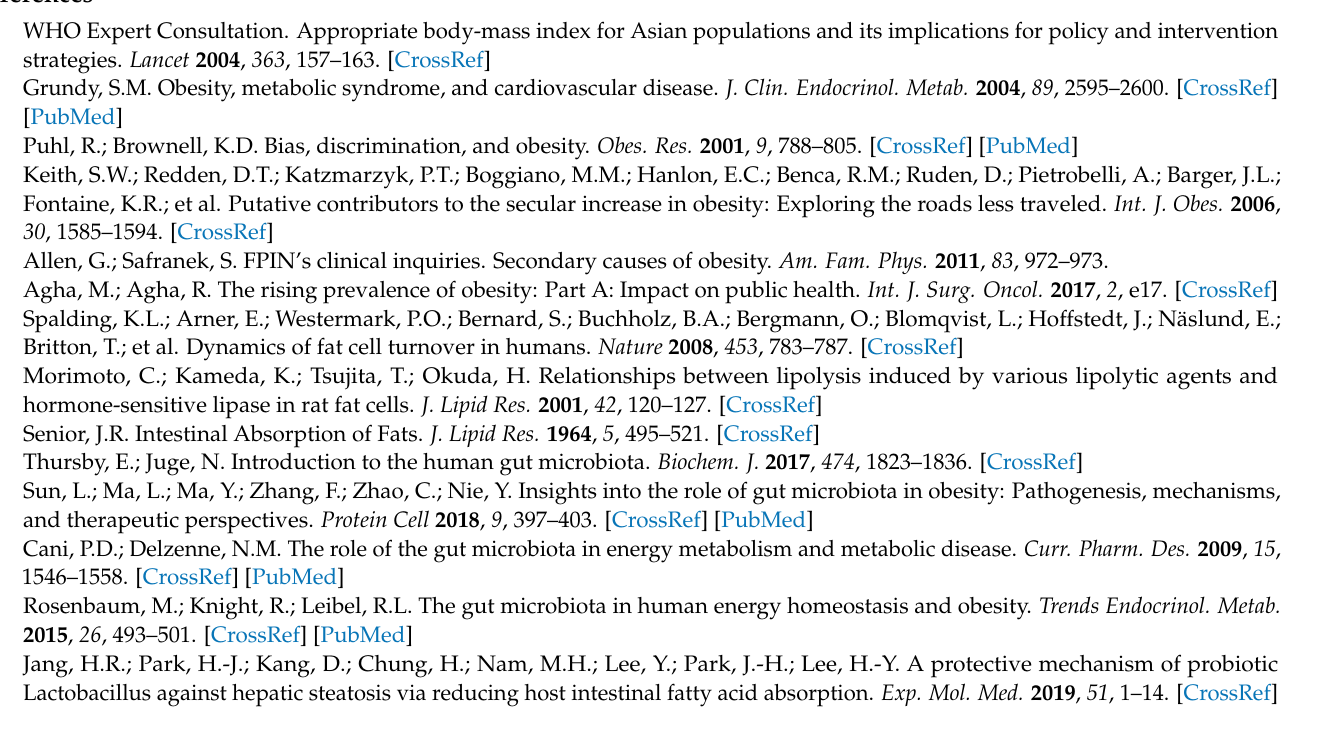
probiotic treatment. Figure S6: Functional pathways analysis after 8-week probiotic treatment by a PICRUSt